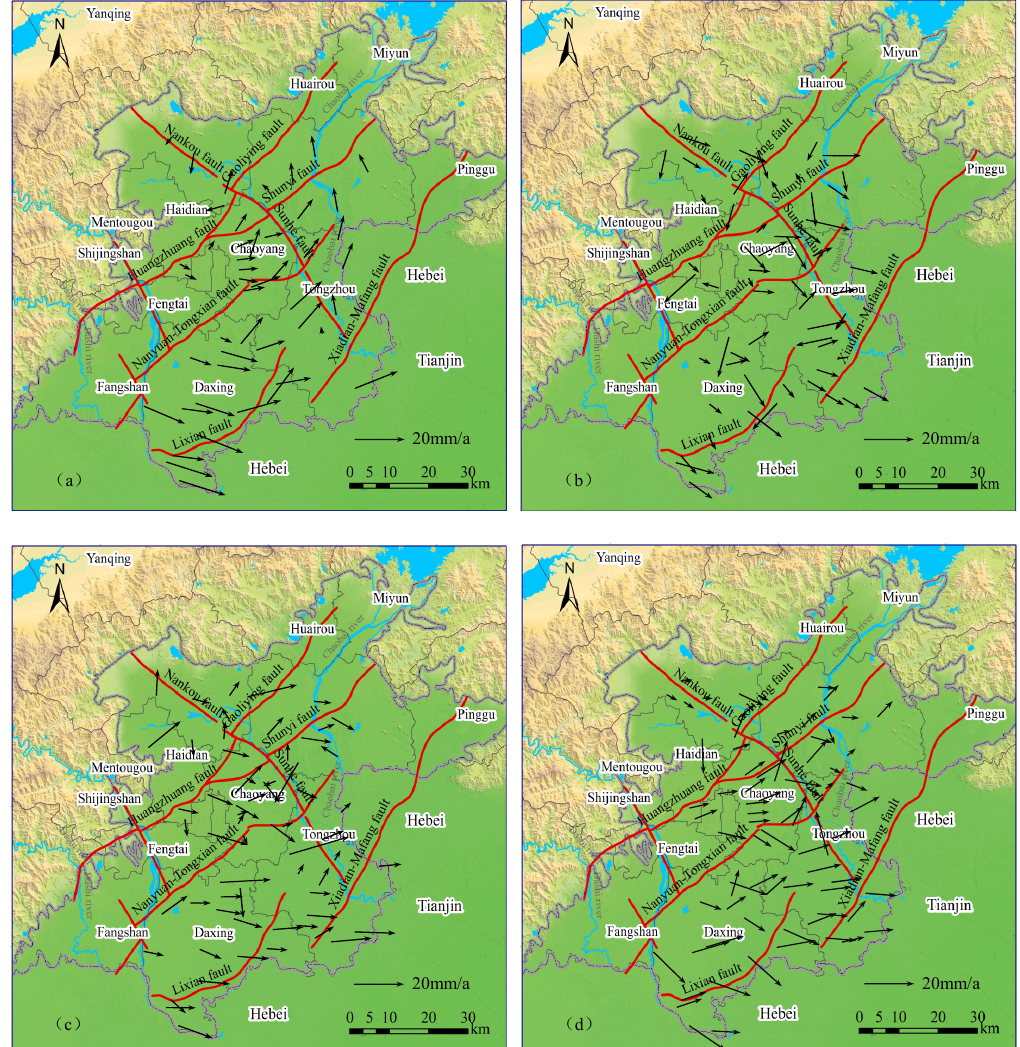
Figure 9. Horizontal velocity of GPS in the Beijing Plain under the Eurasian Reference Frame. (a) 2013~2015. (b) 2016. (c) 2017. (d) 2018.